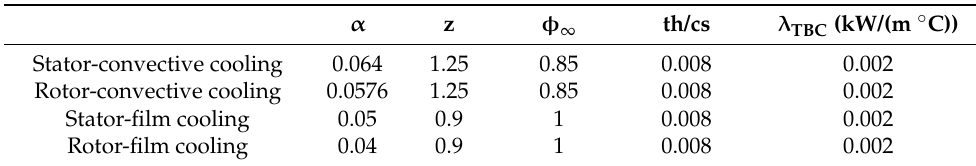
Table 1. Cooling parameters chosen for the turbine model. α z φ ∞ th/cs λ TBC (kW/(m ◦